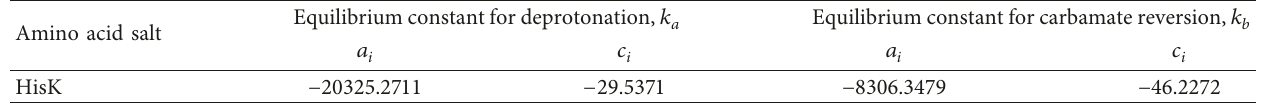
k a and b for equations (25) and (26).